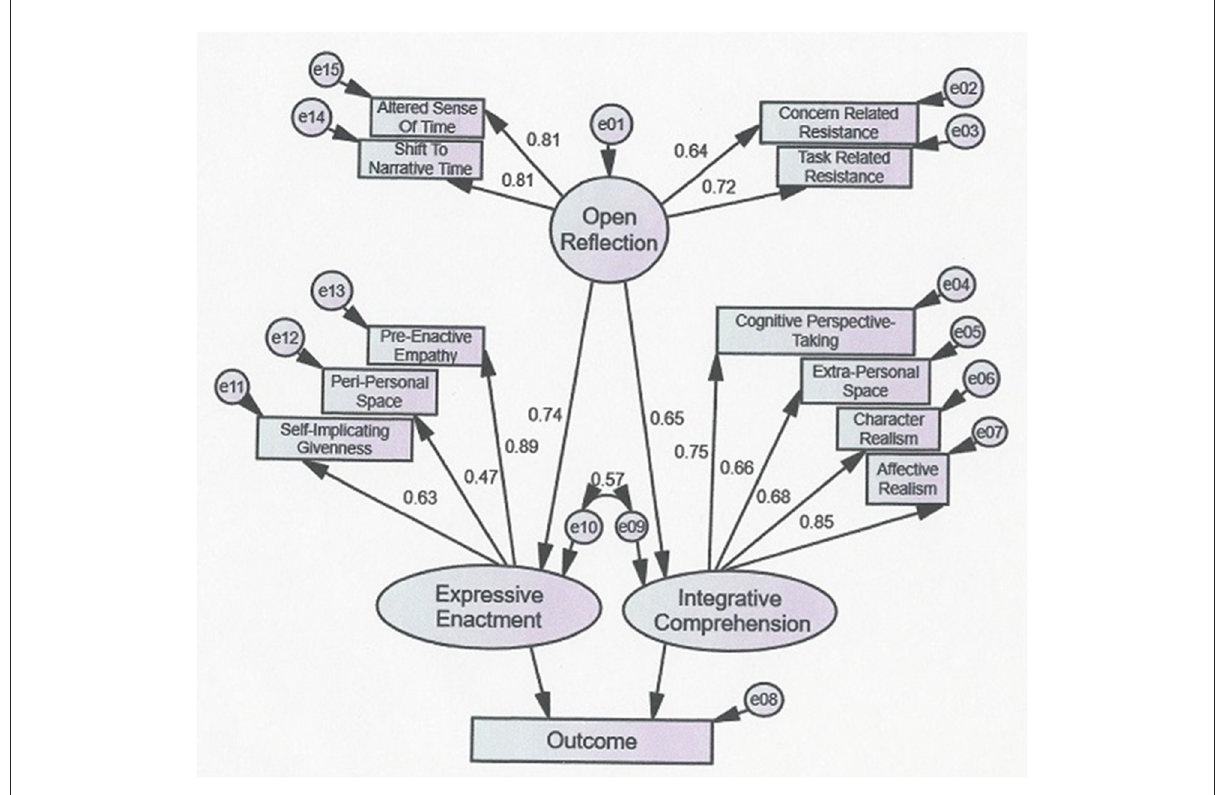
FIGURE1 The basic SEM